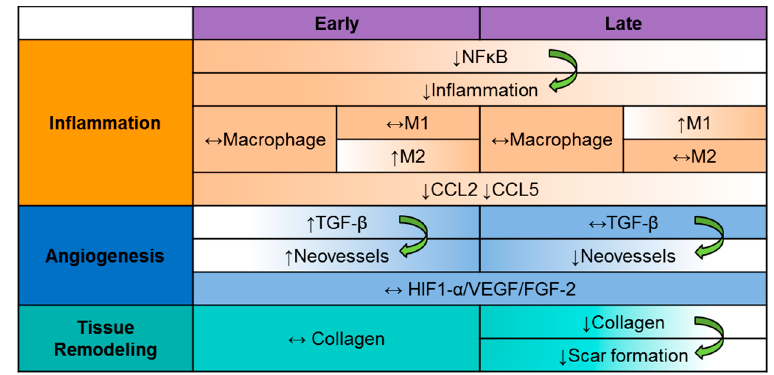
Figure 7. Summary of proposed 35K action in wound healing. Broad-spectrum CC-chemokine inhibition by 35K has a significant impact on key mechanisms involved in wound healing. In addition, 35K enhances wound closure through the early promotion of neovascularisation via the induction of TGF- β , rather than the HIF-1 α /VEGF angiogenic pathway. 35K treatment reduces inflammation via inhibition of NF- κ B, which may help to stave off pathological angiogenesis in the later stages of wound repair, along with the reductions in CCL5 and CCL2 but with no change in macrophages. Finally, 35K suppresses collagen deposition at the late stage of wound healing, but not early, indicative of reduced scar formation.